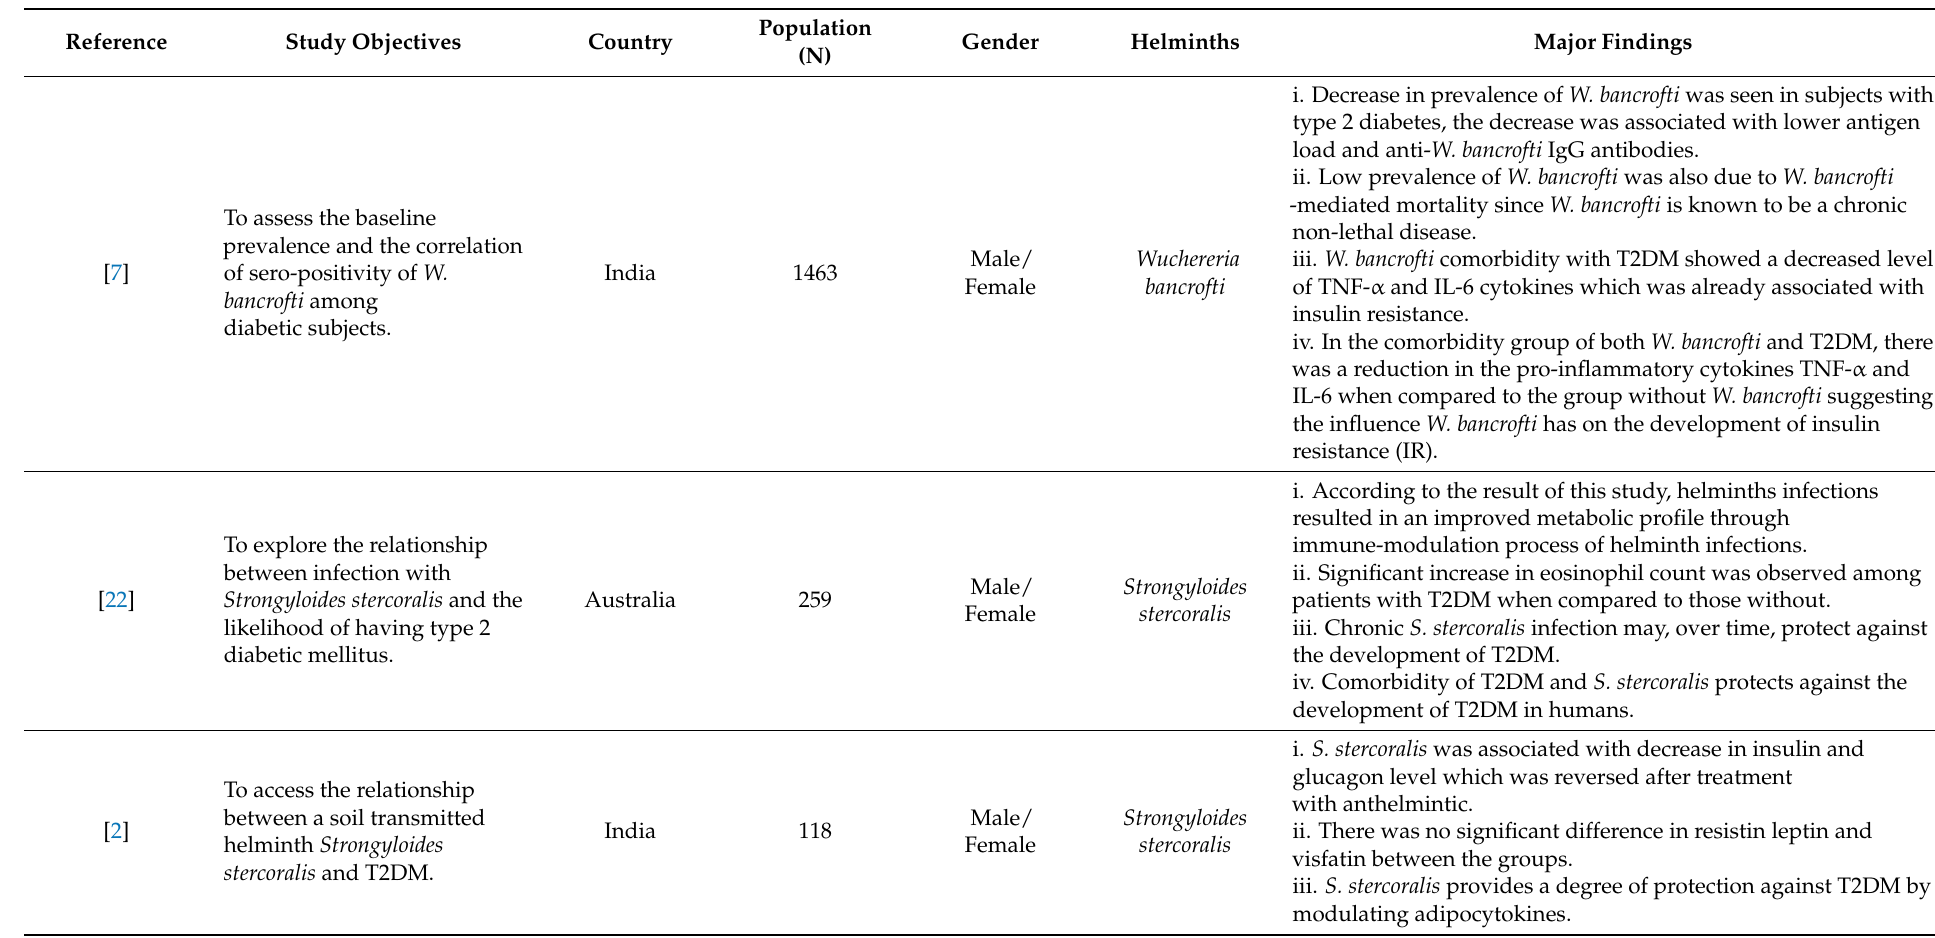
Table 2. Summary of human studies on helminths infection and type 2 diabetes mellitus comorbidity and the outcomes of the